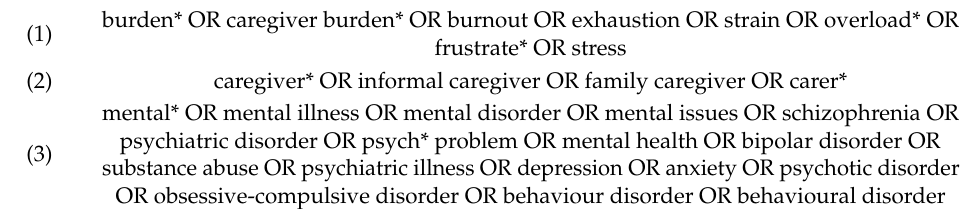
Table 1. Search terms and strategy used in PubMed, Scopus, and